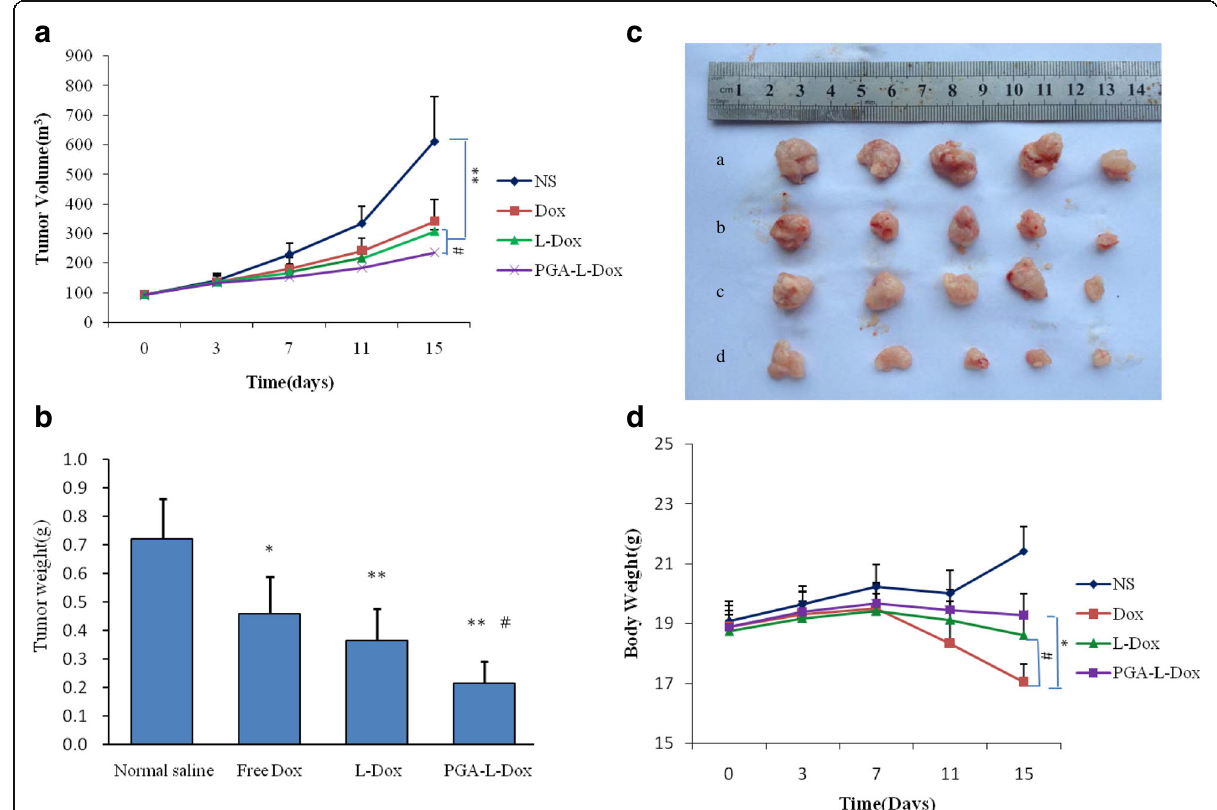
Fig. 6 a In vivo antitumor efficacies of various formulations groups toward HepG2 cell-bearing nude mice model ( n = 5). ** p < 0.01 vs. NS group; # p < 0.05 vs. L-Dox group. b The tumor weight from various formulations groups ( n = 5). * p < 0.05, ** p < 0.01 vs. normal saline group; # p < 0.05 vs. L-Dox group. c Photograph of excised tumors from various formulations groups ( n =5) a : normal saline, b : L-Dox, c : free Dox, and d : PGA-L-Dox. d Body weight changes of HepG2 cell-bearing nude mice in the course of treatment with various formulations groups ( n =5). * p <0.05 vs. Dox group; # p <0.05 vs. L-Dox